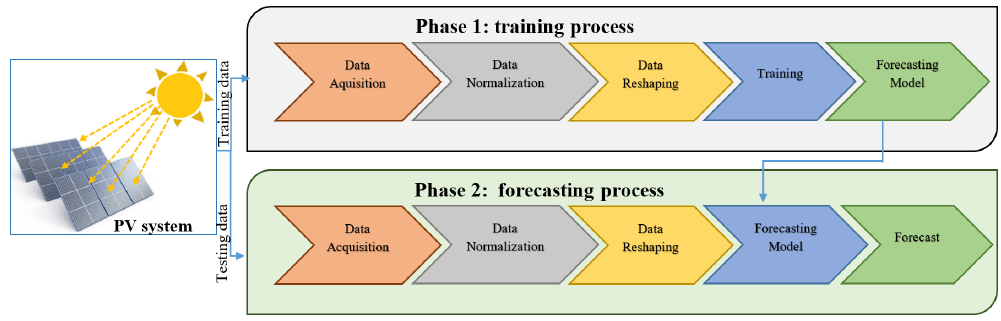
Figure 3. Schematic presentation of deep learning-based photovoltaic (PV) power